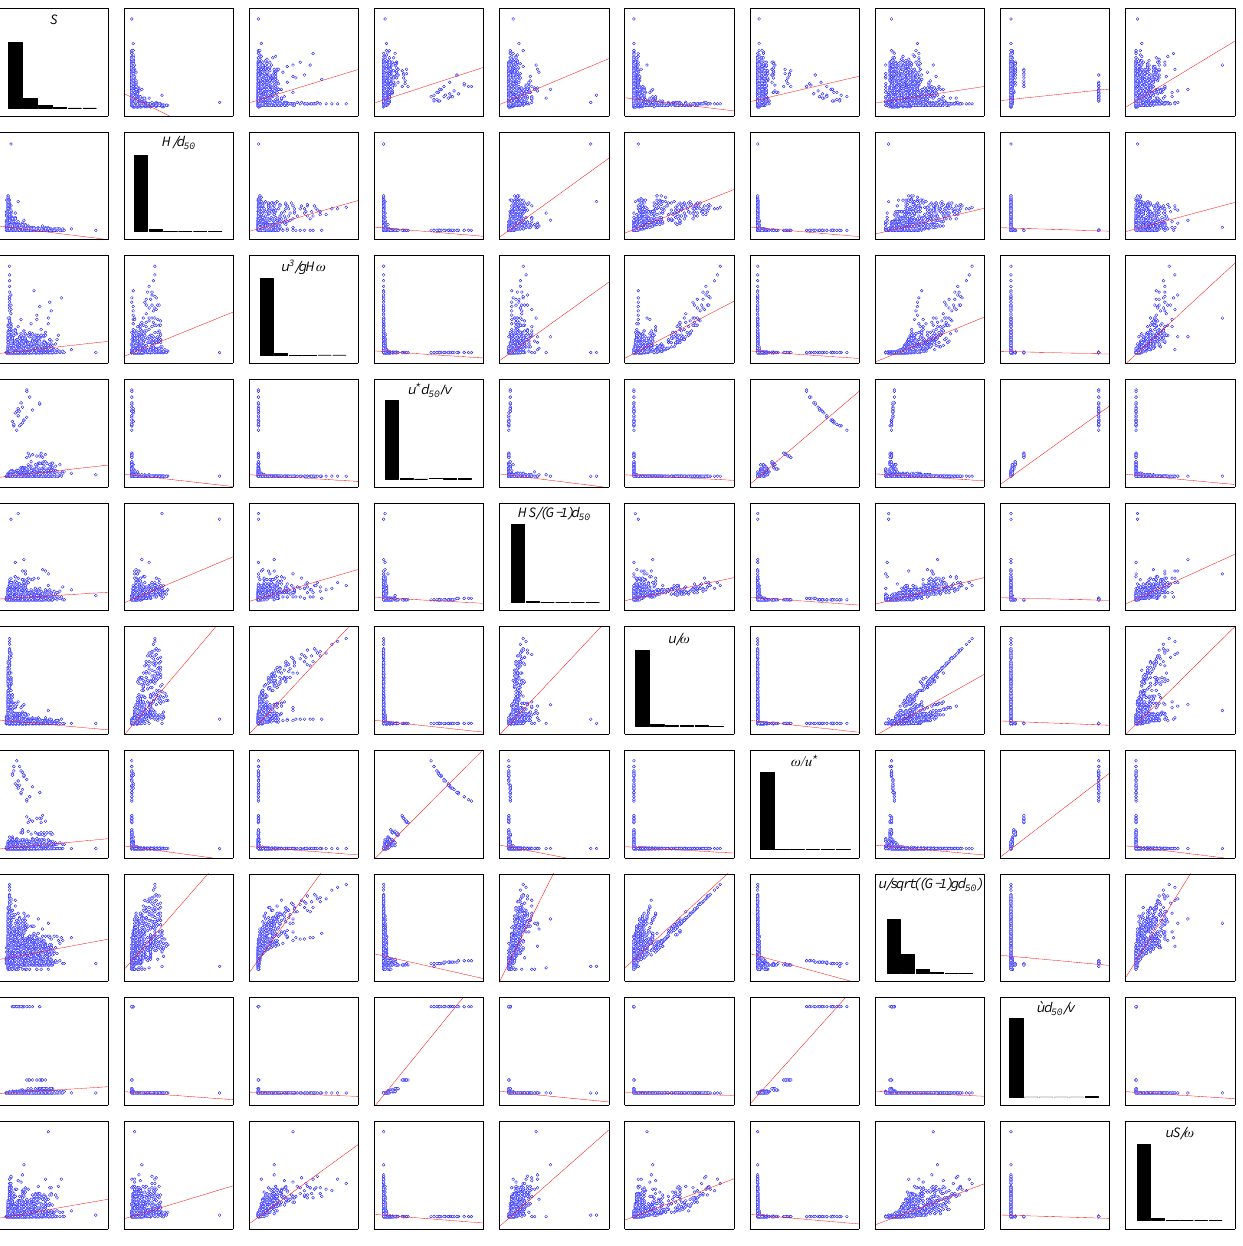
Figure 2. Matrix plot that shows the correlation among ten drivers used in this study. To apply the PCA to the drivers, a symmetrical correlation matrix was created Table 1. General characteristics of the calculated principal components (PCs). (Table S2). The matrix’s eigenvalues and their corresponding eigenvectors were Conserved Variance of Cumulative Conserved Variance of PCs Eigenvalue the Drivers the Drivers